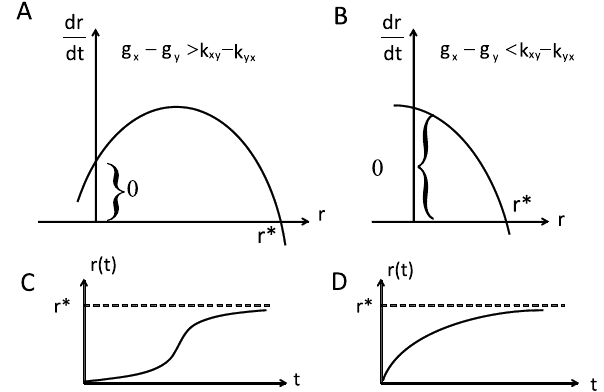
Figure 2. The re-equilibrium of the cell subpopulations after cell sorting can have different dynamical behaviors. A . Cell differential growth rates are bigger than cell differential transition rates. The time derivative of cell ratio is non-monotonic before reaching the fixed ratio r (cid:2) . B . Cell differential growth rates are smaller than the cell differential transition rate. The time derivative of cell ratio is monotonically decreasing before reaching the fixed ratio r (cid:2) . C . Cell re-equilibrium dynamics is sigmoidal for the condition shown in A. D . Cell re- equilibrium dynamics is logistical for the condition shown in